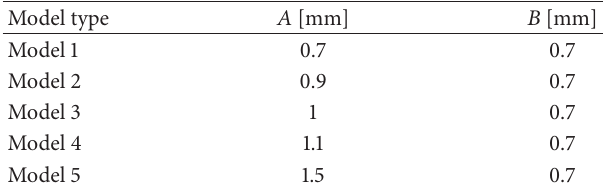
Table 2: Parameters of